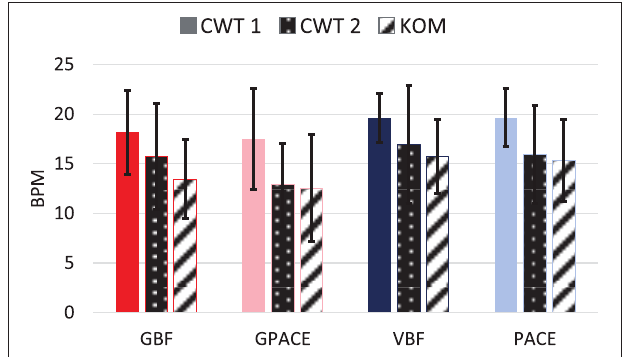
FIGURE 10 | Average breathing rates during CWT 1, CWT 2, and KOM for all